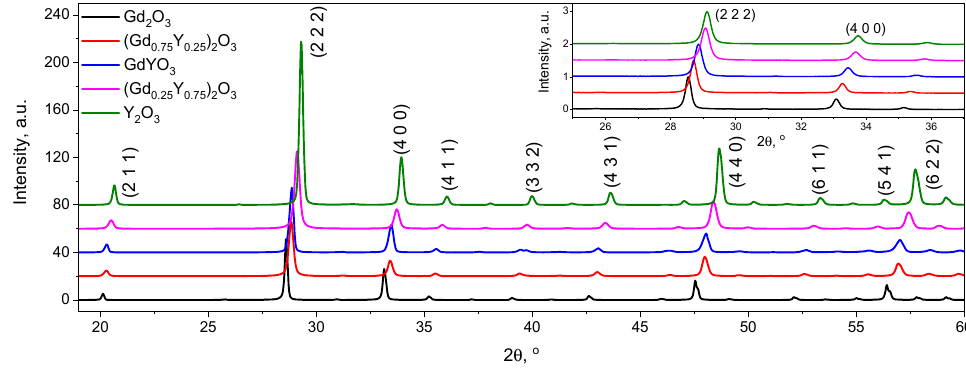
Figure 2. XRD patterns of (Gd 1 − x Y x ) 2 O 3 powders, where x = 0; 0.25; 0.5; 0.75, 1; the inset contains the most intense peaks on a larger scale. Table 1. Crystal characteristics of (Gd 1 − x Y x ) 2 O 3 powders .